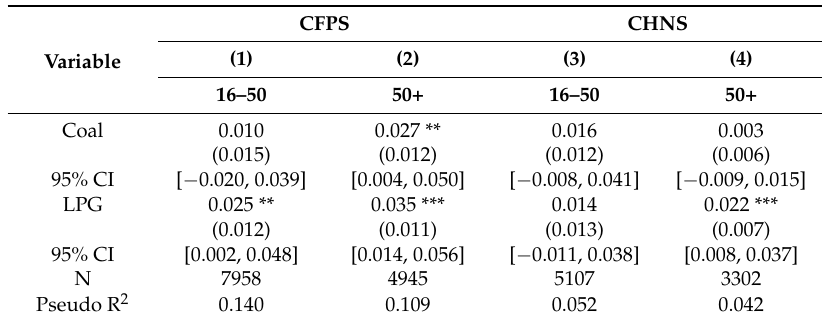
Table A3. Ordered probit estimates for cooking fuel choice on women self-reported health in rural area: CFPS 2010–2012 and CHNS 1991–2009.